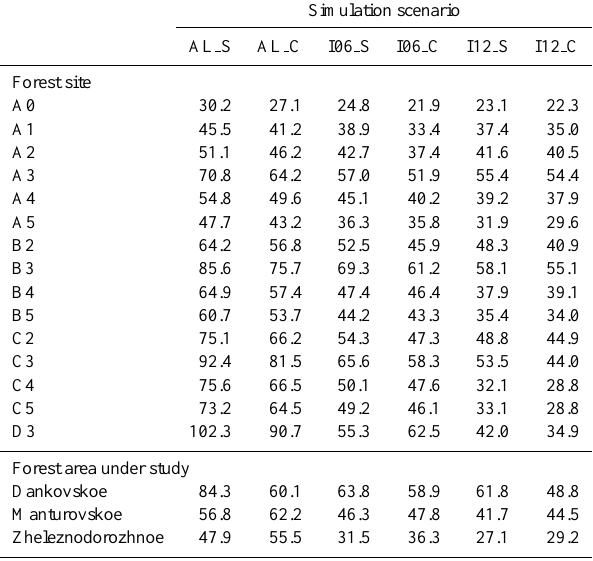
Table 4. Carbon accumulation, kgCha − 1 yr − 1 per 1kgN ha − 1 yr − 1 deposited with different levels of deposition of nitro- gen compounds (AL – ambient level, I06 – increase of 6kgN narios ( S – ambient climate, C – climate change). Values for dif-